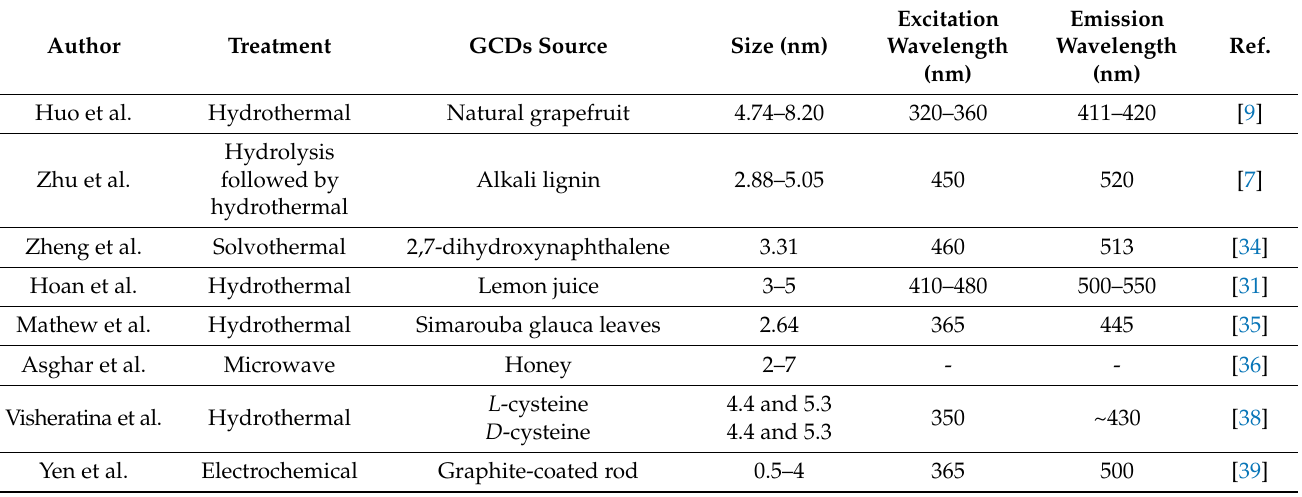
Table 4. Size and optical properties of the hydrothermally (solvothermally) prepared GCDs are summarized.